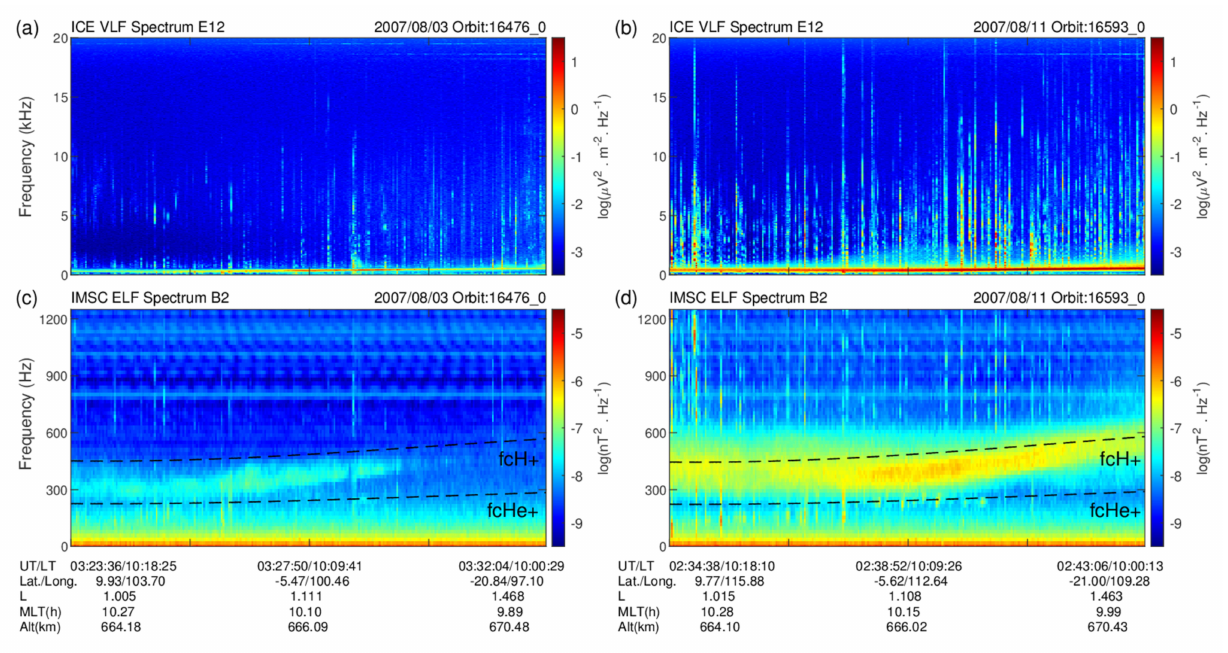
Figure 6. The VLF electric spectrum (E12—frequency: 0–20 kHz) and ELF magnetic spectrum (B2—frequency: 0–1250 Hz), respectively: ( a , c ) semi-orbit 16476_0 and ( b , d ) semi-orbit 16593_0. The intensity is color-coded according to the color scale on the right. The two black dashed curves in ( c , d ) indicate the ion (H + and He + ) gyrofrequencies, respectively.